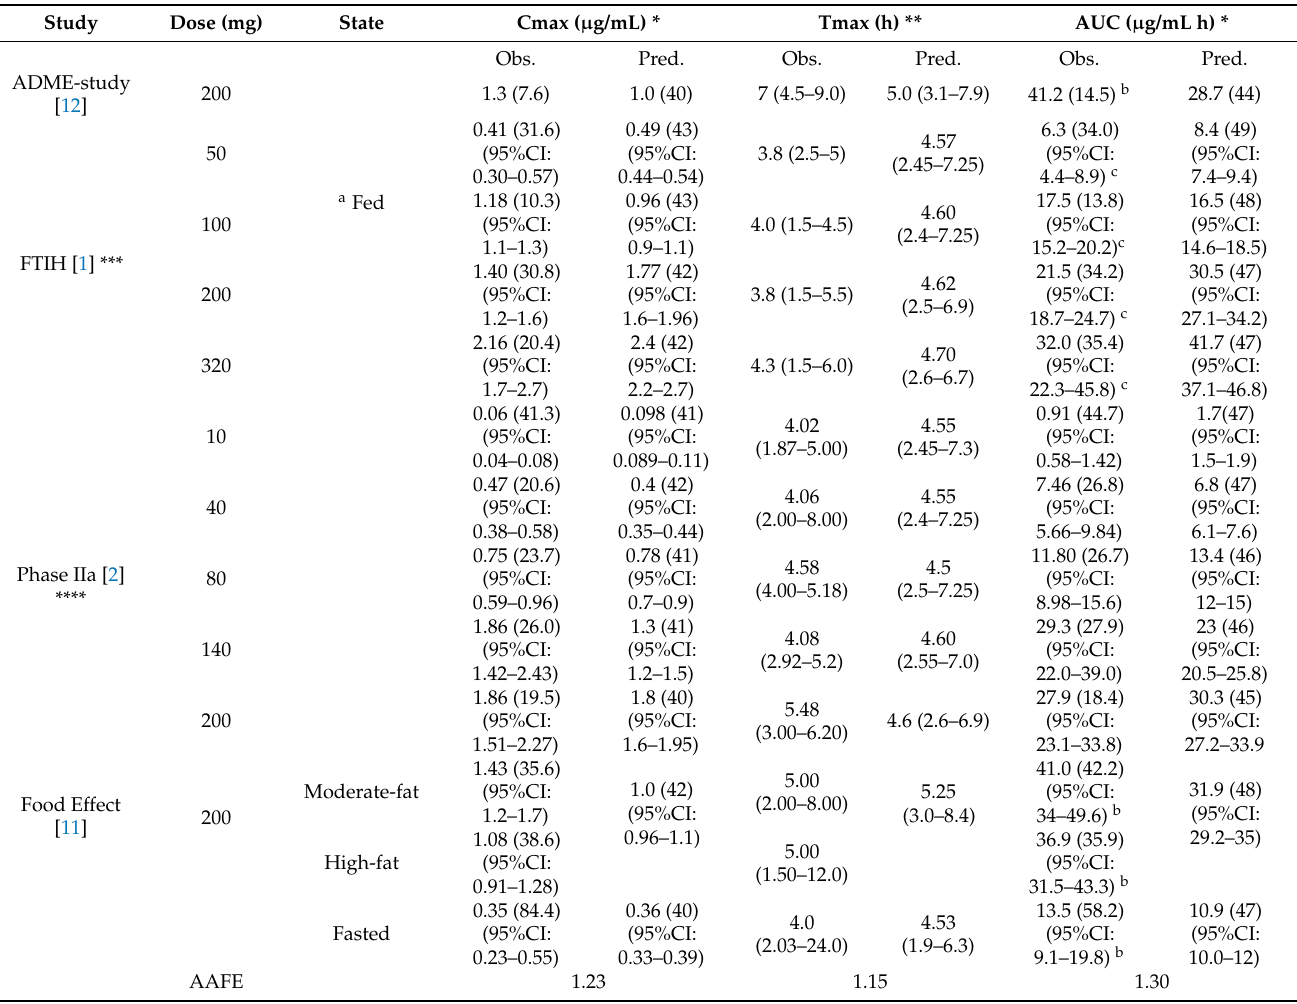
Table 8. Simulated and Observed Pharmacokinetic Parameters of GSK254 following administration of an IR-tablet at different doses in fasted and fed